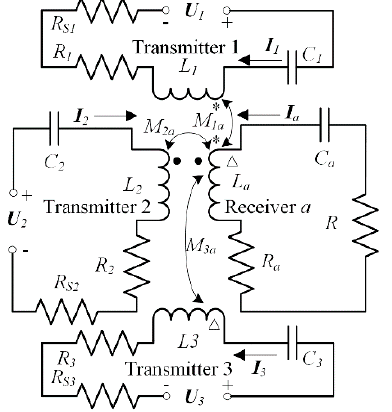
Figure 2. Lumped circuit model of the three-phase-shifted drive omnidirectional WPT system.